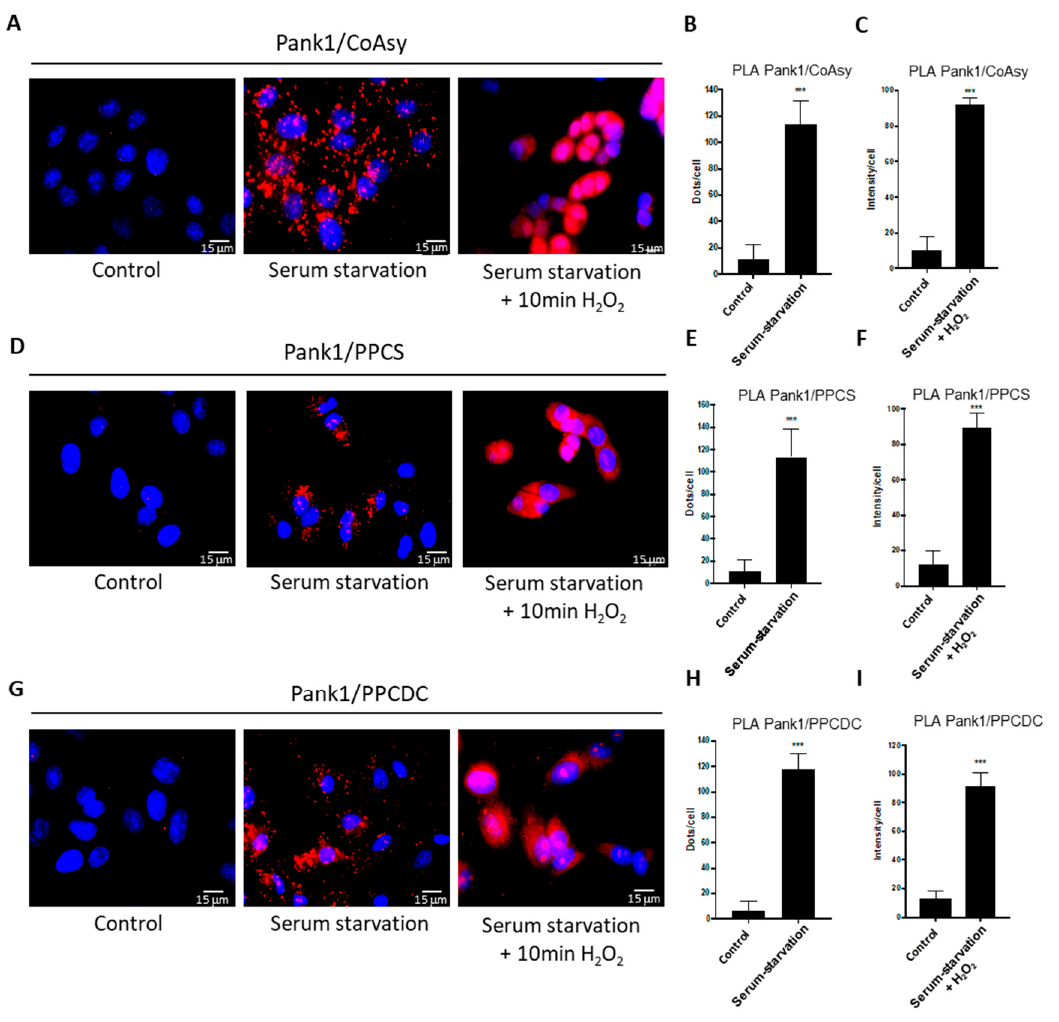
Figure 5. Asociation between endogenous enzymes of the CoA biosynthetic pathway is induced in A549 cells in response to serum starvation and oxidative stress. ( A , D , G ) Pank1 interacts with CoAsy, PPCS and PPCDC in A549 cells in response to serum starvation for 24 h or serum starvation followed by 10 min treatment with 500 µ M H 2 O 2 . Nuclei are stained with DAPI (blue); proximity ligation assay (PLA) was performed for Pank1 and other enzymes of the CoA biosynthesis (Red). PLA images are representative of three independent experiments. ( B , E , H ) Relative quantitation of fluorescent dots/cell of Pank1/CoAsy, Pank1/PPCS and Pank1/PPCDC assembly in control untreated and serum starved A549 cells from ( A , D , G ). Data are presented as mean ± standard error of the mean (SEM) from n = 3 experiments (*** p <0.001). ( C , F , I ) Relative quantification of the mean fluorescence intensity per cell of Pank1/CoAsy, Pank1/PPCS and Pank1/PPCDC for control untreated and serum starved + H 2 O 2 treated cells from ( A , D , G ). Data are presented as mean ± SEM from n = 3 experiments (*** p < 0.001).